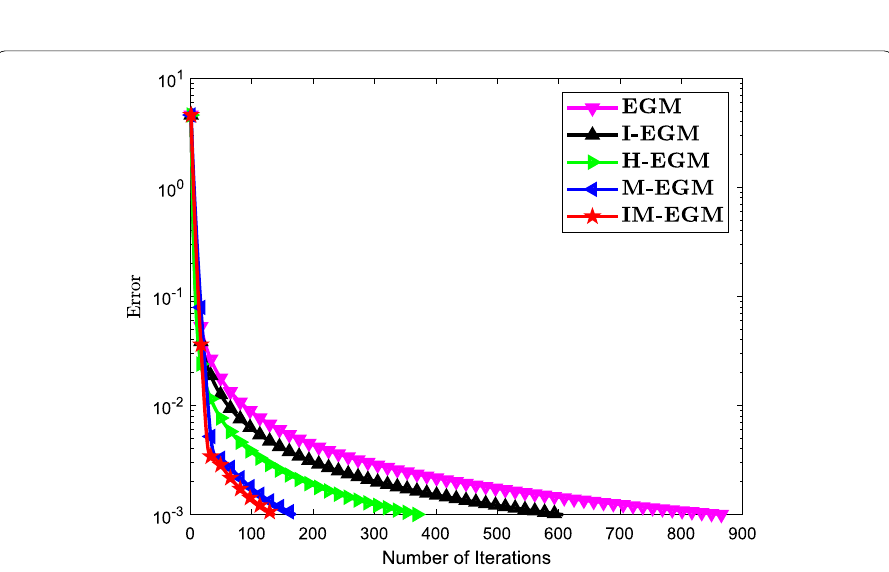
Figure 3 Numerical comparison of Algorithm 1 and Algorithm 2 using Algorithm 1 in [52], Algorithm 2 in [51], and Algorithm 1 in [18], while N = 20 for the error term 10